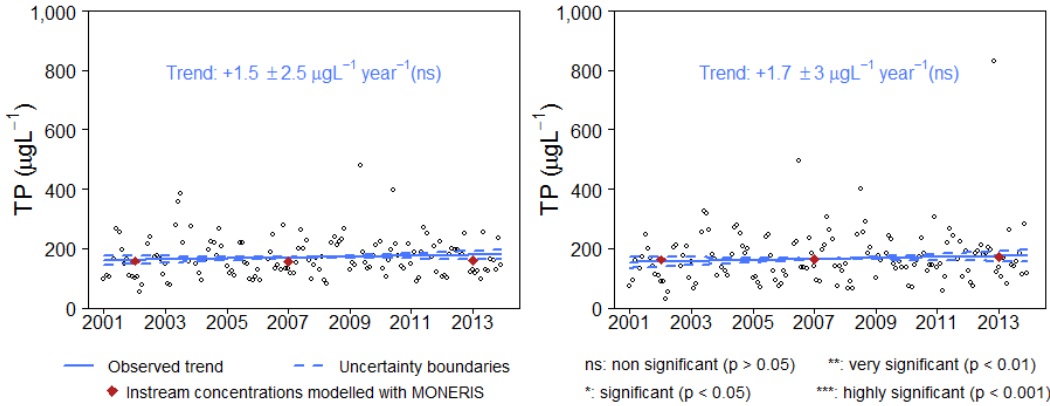
Figure 5. Observed trends of TP concentration compared to modelled TP concentrations for the years 2002, 2007 and 2013 in the two sub-catchments of the river Antiesen: ( a ) upstream; and ( b ) downstream. Plotted values of TP concentrations correspond to flow-adjusted data. They were calculated by adding the residuals obtained from the concentration versus flow regression to the mean concentration for the period under study [25].